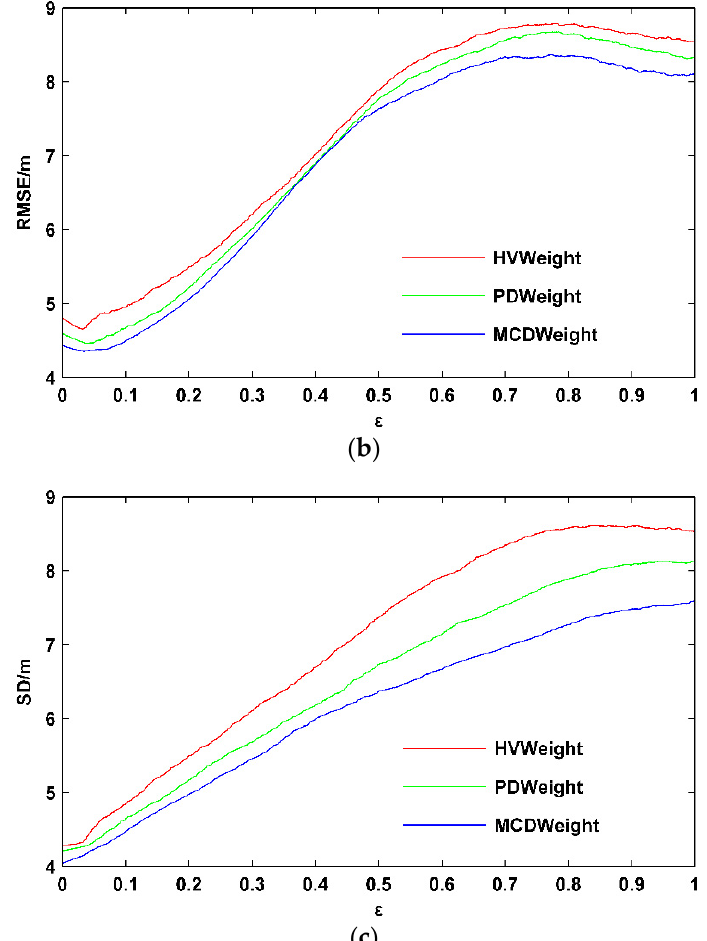
Figure 11. Forest height statistical indicator changes with the ε . ( a ) Average bias; ( b ) RMSE; ( c ) Standard deviation.